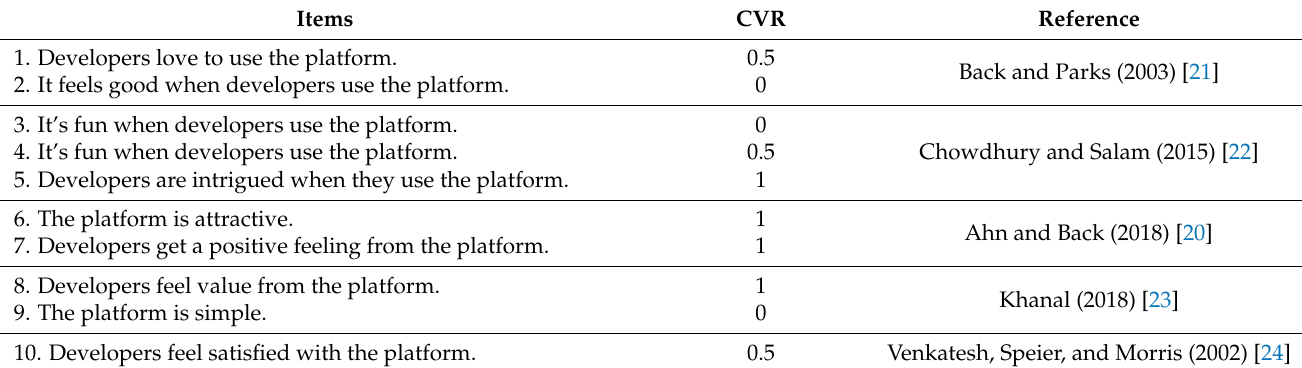
Table 2. Pilot items for the measurement of affective factor and calculated CVRs.